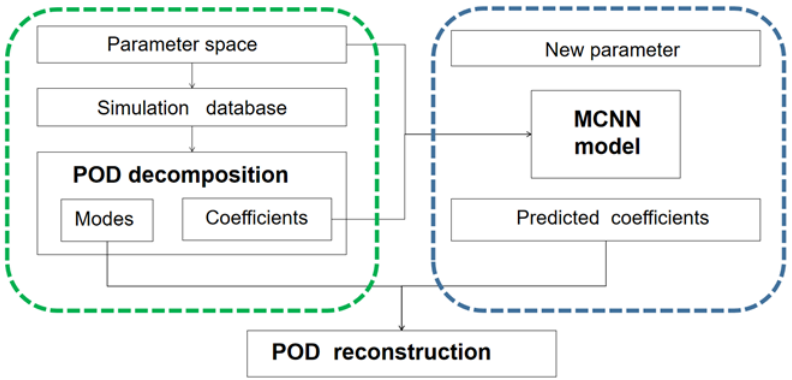
Figure 4. General framework of POD-MCNN model.